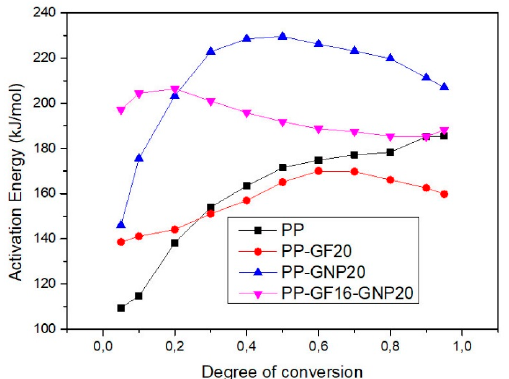
Figure 9. Dependence of the activation energy on the degree of conversion as calculated with Friedman’s method for neat PP, and PP–GF20, PP–GNP20, PP–GF16–GNP20